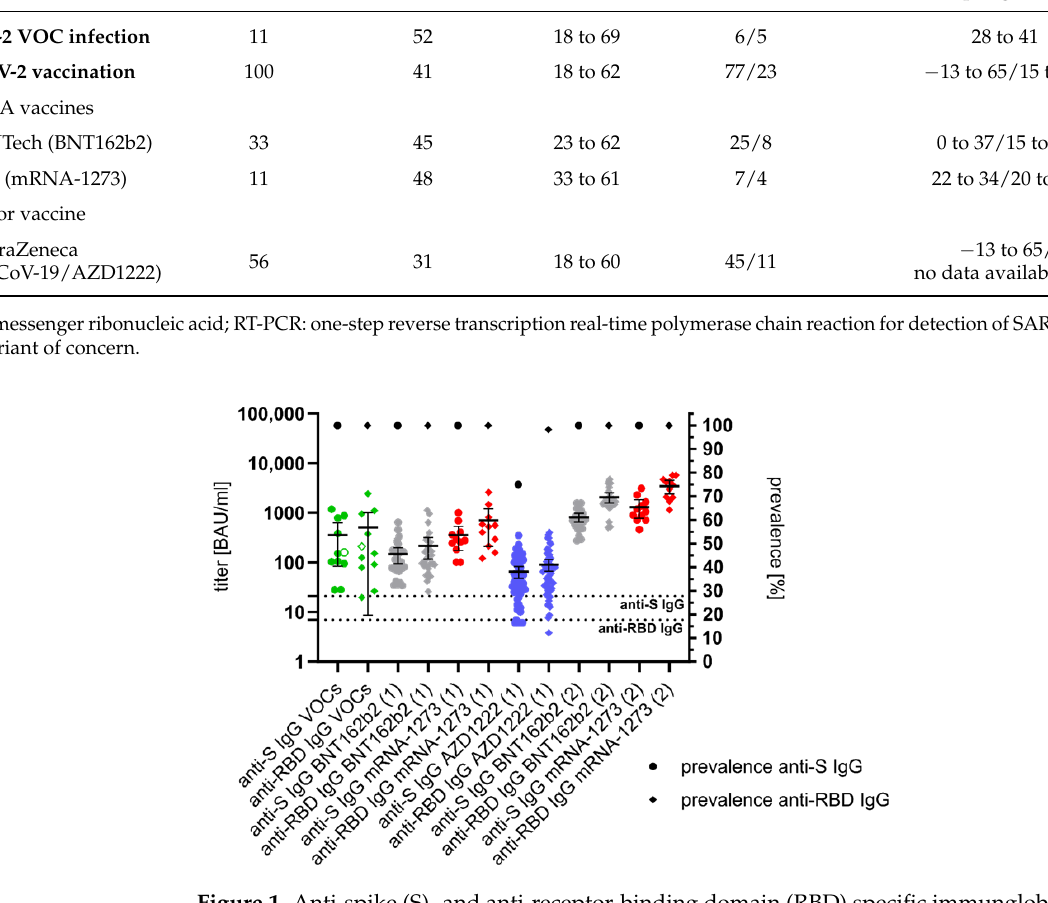
Figure 1. Anti-spike (S)- and anti-receptor-binding domain (RBD) specific immunglobuline G (IgG) response ≥ 21 days after infection with SARS-CoV-2 variants of concern (VOCs: B.1.1.7, filled green dots or diamonds; B.1.351, empty green dots or diamonds) or after first (1) and second vaccination (2) with messenger ribonucleic acid (BNT162b2, grey dots or diamonds; mRNA-1273, red dots or diamonds) and vector (AZD1222, blue dots or diamonds) vaccines. The mean titer and the 95% confidence intervals are given per each study group. All titers were measured in Binding Antibody Units per milliliter (BAU/mL). The prevalence of anti-S/anti-RBD IgG is indicated by a black dot or diamond. The cut-off values for seropositivity (in BAU/mL) of the anti-S and anti-RBD IgG assays are indicated by dotted lines.